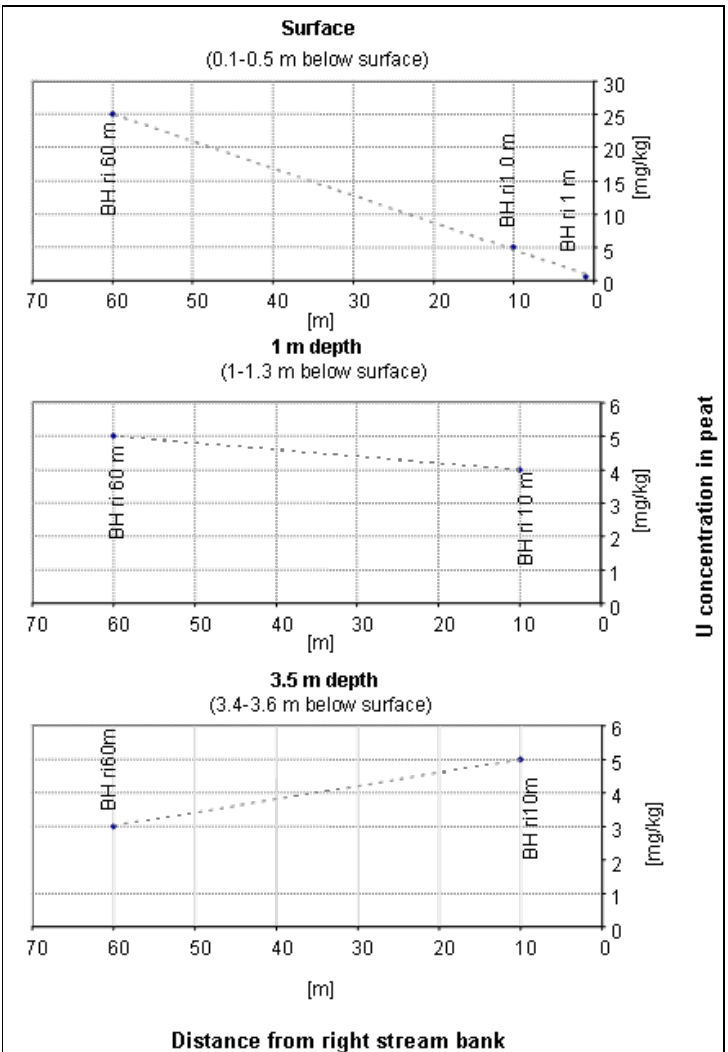
Figure 11. Horizontal stream distance gradients of U concentration in peat at different depths (GMB, portion